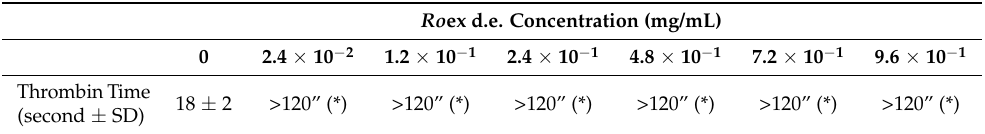
Table 5. Thrombin Time of different concentration of Ro ex. Data are mean ± SD of six replicates. (*) Value statistical different versus control (human plasma diluted 1:1 with 60% v / v Et-OH